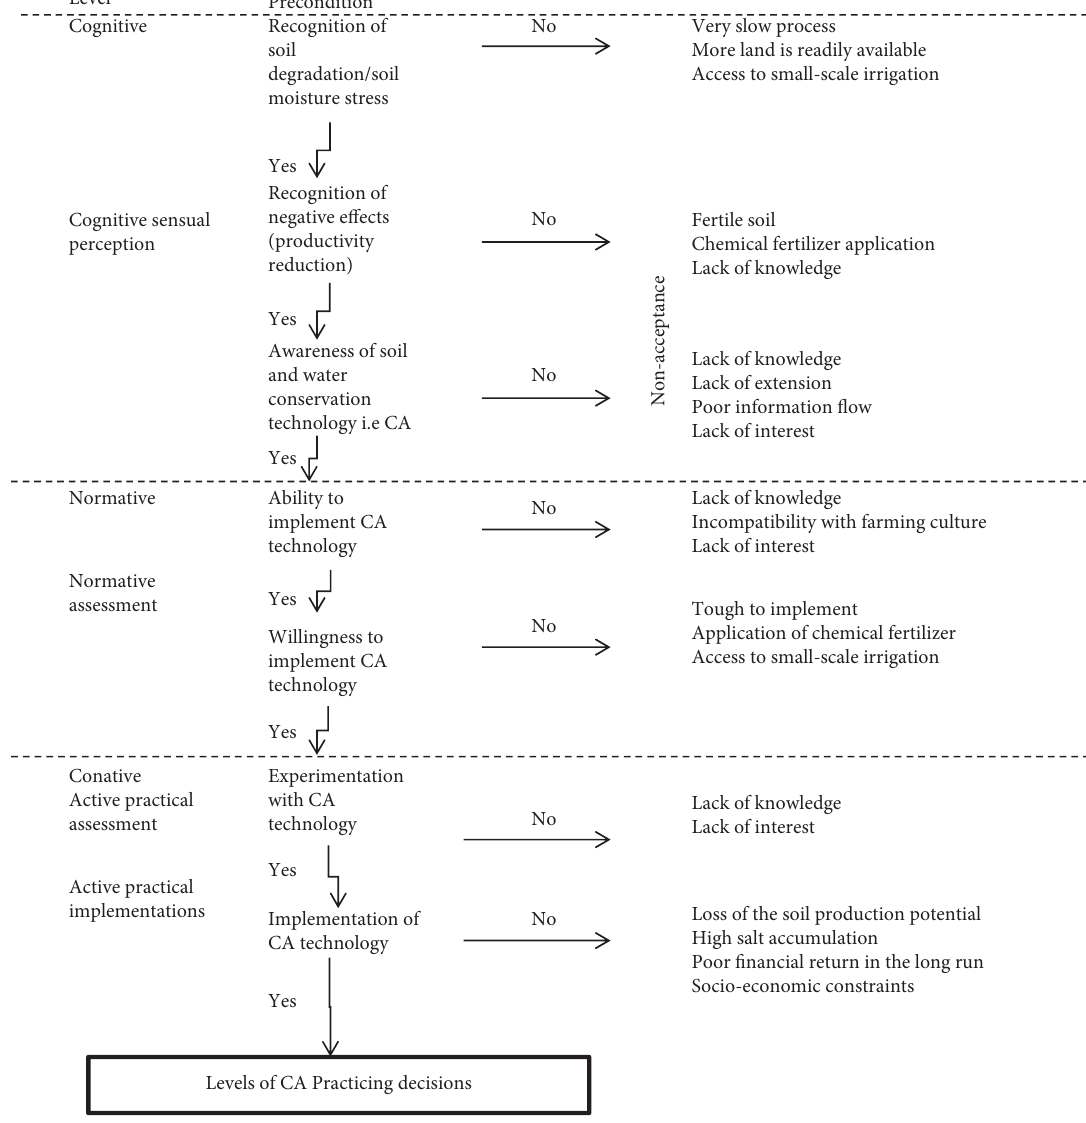
Figure 1: Levels and preconditions of the practicing process adapted from